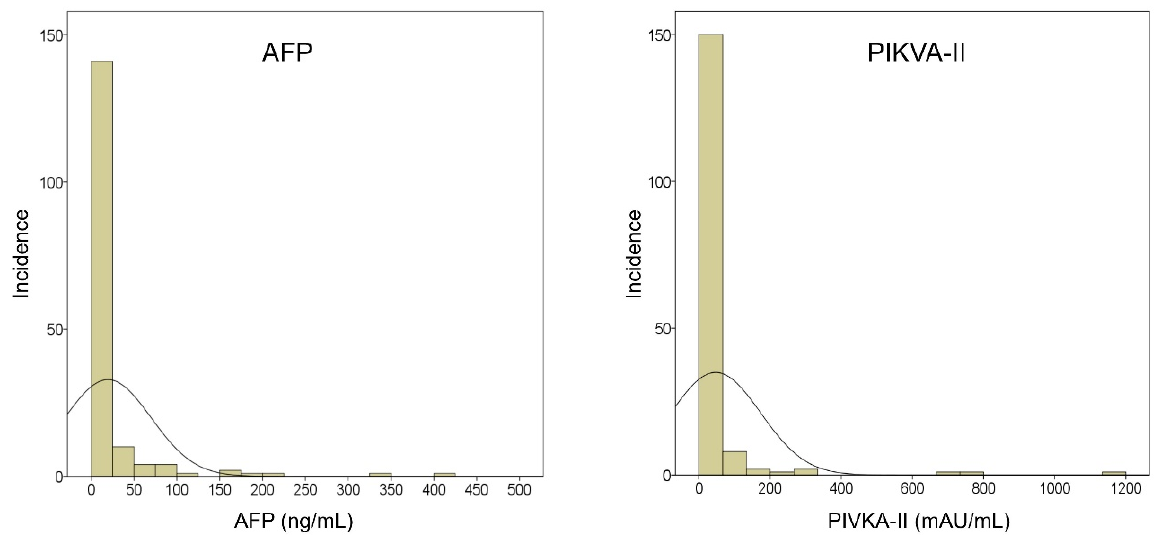
Figure 2. Distribution of α‐ fetoprotein (AFP) and protein induced by Vitamin K absence or antago ‐ nist ‐ II (PIVKA ‐ II) expression measured within two weeks before transplantation in patients with hepatocellular carcinoma of complete pathological response.